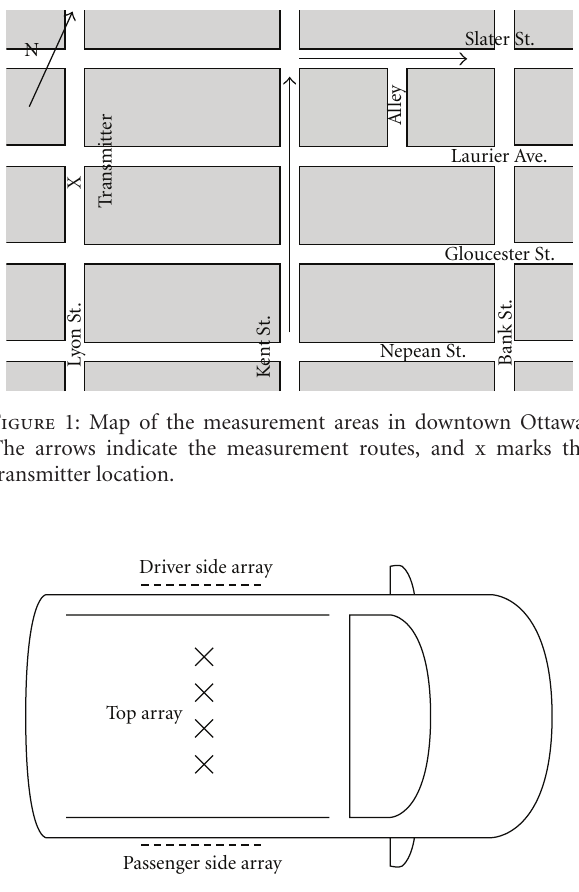
Figure 2: Positions of the top, driver side, and passenger side arrays on the measurement vehicle.